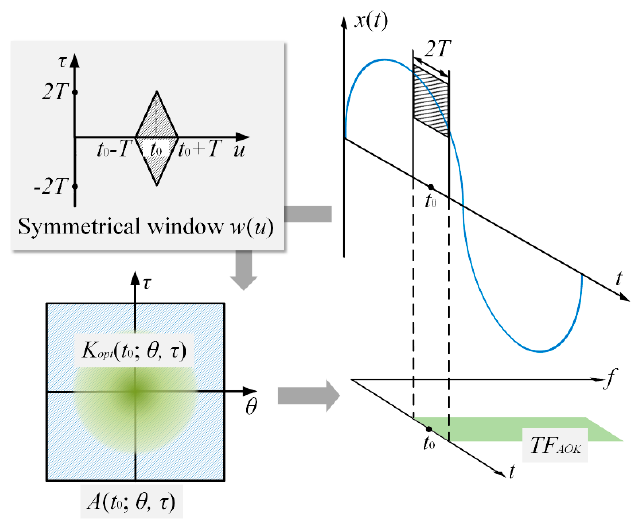
Figure 1. Principle of adaptive optimal-kernel time–frequency representation.